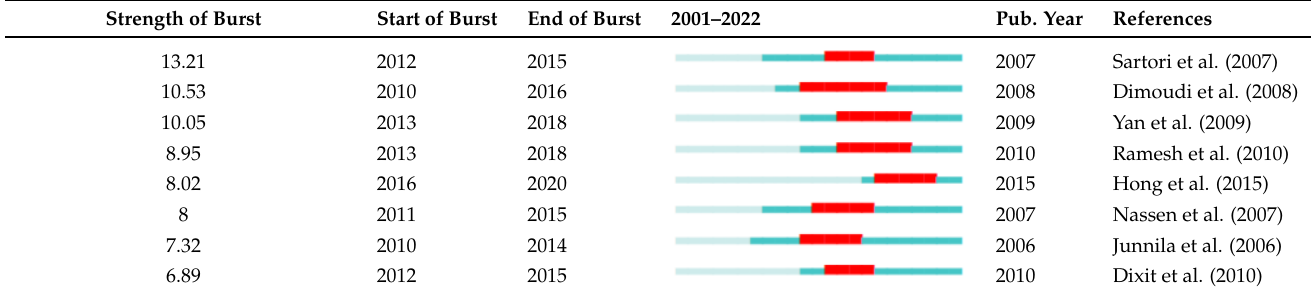
Table 2. Top 25 references with the strongest citation bursts in